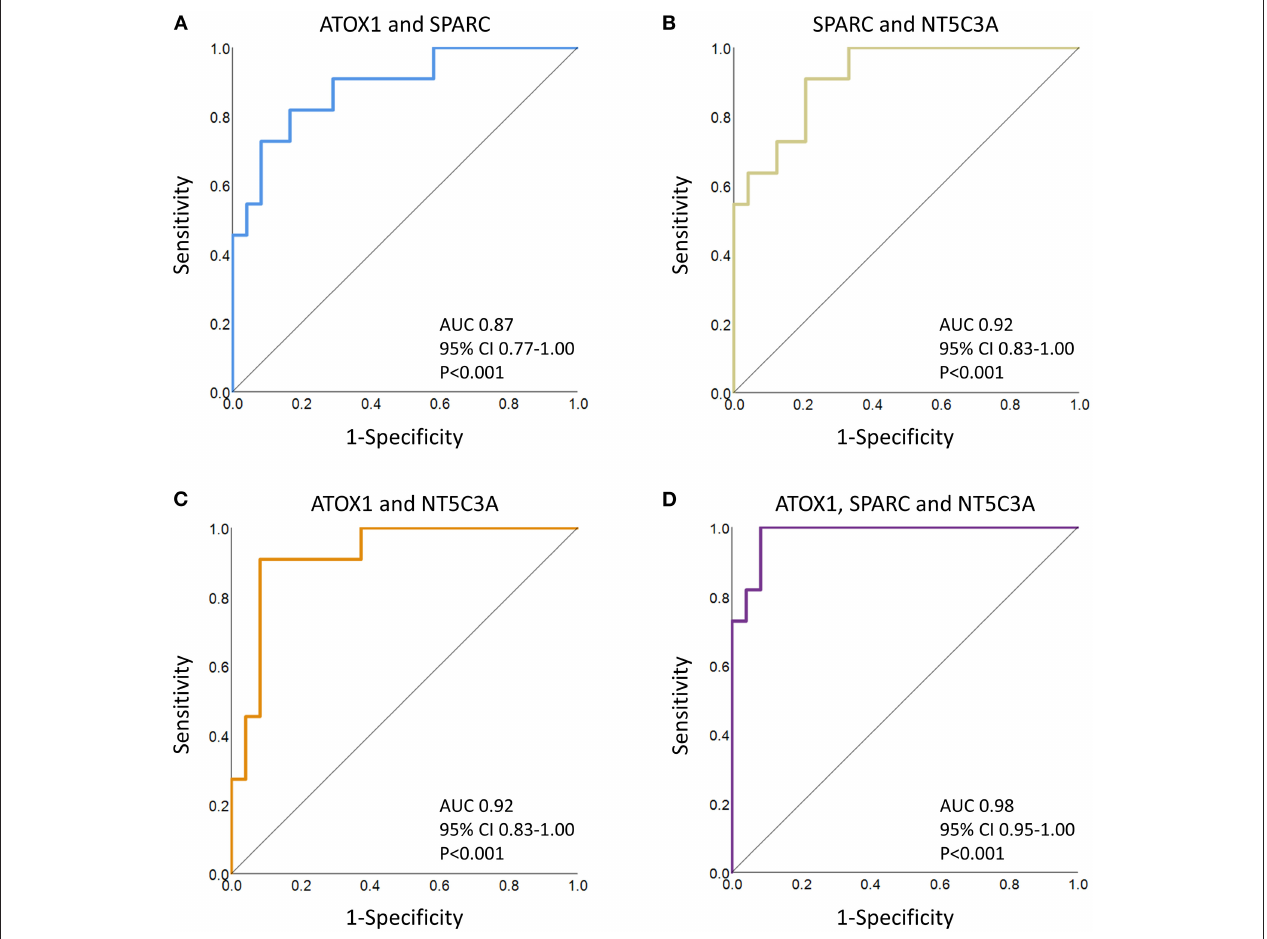
FIGURE 2 | ROC curve analyses of several protein combinations for concussion diagnosis. (A) ATOX1 and SPARC; (B) SPARC and NT5C3A; (C) ATOX1 and NT5C3A; (D) ATOX1, SPARC and NT5C3A. The AUCs, confidence intervals (CI) and P values are indicated. When predicted values for the three leading proteins, as determined by regression analyses, were combined, the AUC increased to 0.98 ( P < 0.001). The addition or substitution of other proteins failed to significantly improve the